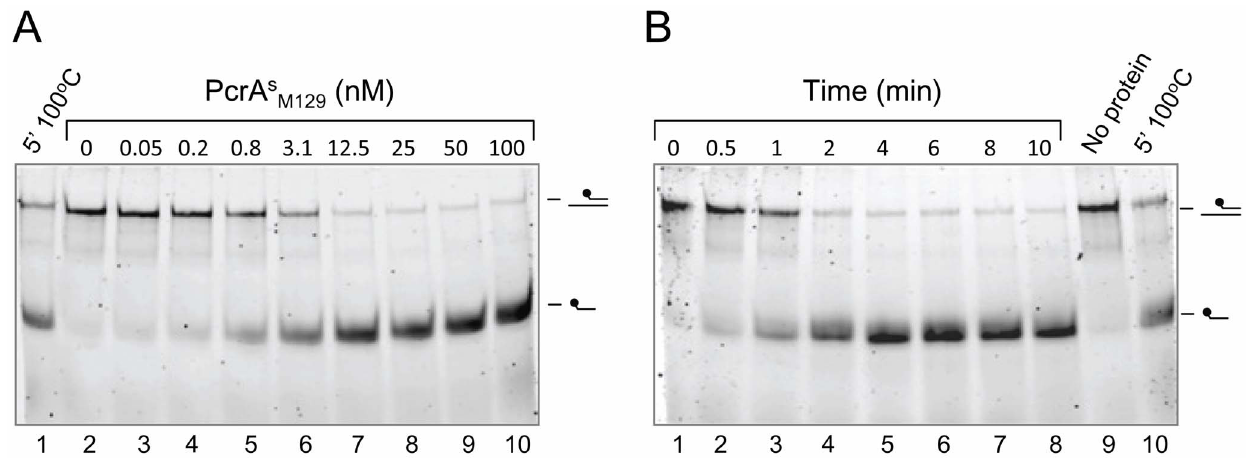
Figure 4. Protein concentration- and time-dependence of the DNA helicase activity of PcrA s M129 . (A) Protein concentration-dependence of the DNA helicase activity. The DNA unwinding reactions were performed as described in Materials and Methods, using 4 nM of substrate ‘a’ and a range of PcrA s M129 concentrations (0–100 nM, as indicated above the lanes). Lane 1 shows a control reaction in which protein was omitted, and incubation was performed for 5 min at 100 u C instead of at 37 u C. (A) Time course of the DNA helicase activity of PcrA s M129 (at 0.1 m M) using substrate ‘a’ (at 4 nM). Reactions were performed at 37 u C for the times indicated above the lanes. The control reactions shown in lanes 9 (‘No protein’) and 10 (‘5 9 100 u C’) were incubated for 5 min at 37 u C before deproteinization of the